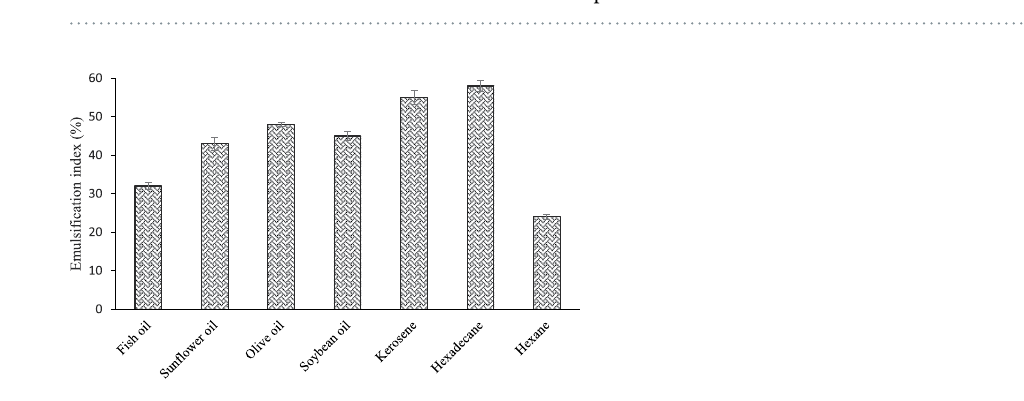
Figure 3. ST value of 39.01 calculated at distance between − 2 and 2 of the BS solution obtained from P. dextrinicus SHU1593. The surface of the BS solution corresponds to zero level.